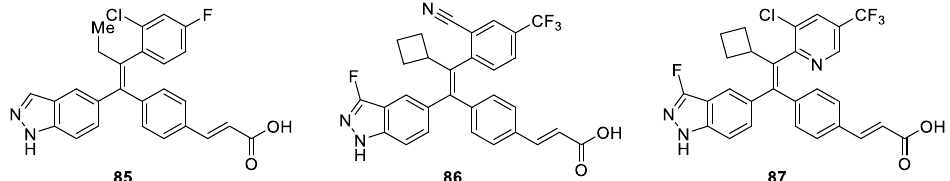
Figure 7. Chemical structures of 1 H -indazoles derivatives 85 , 86 and 87.